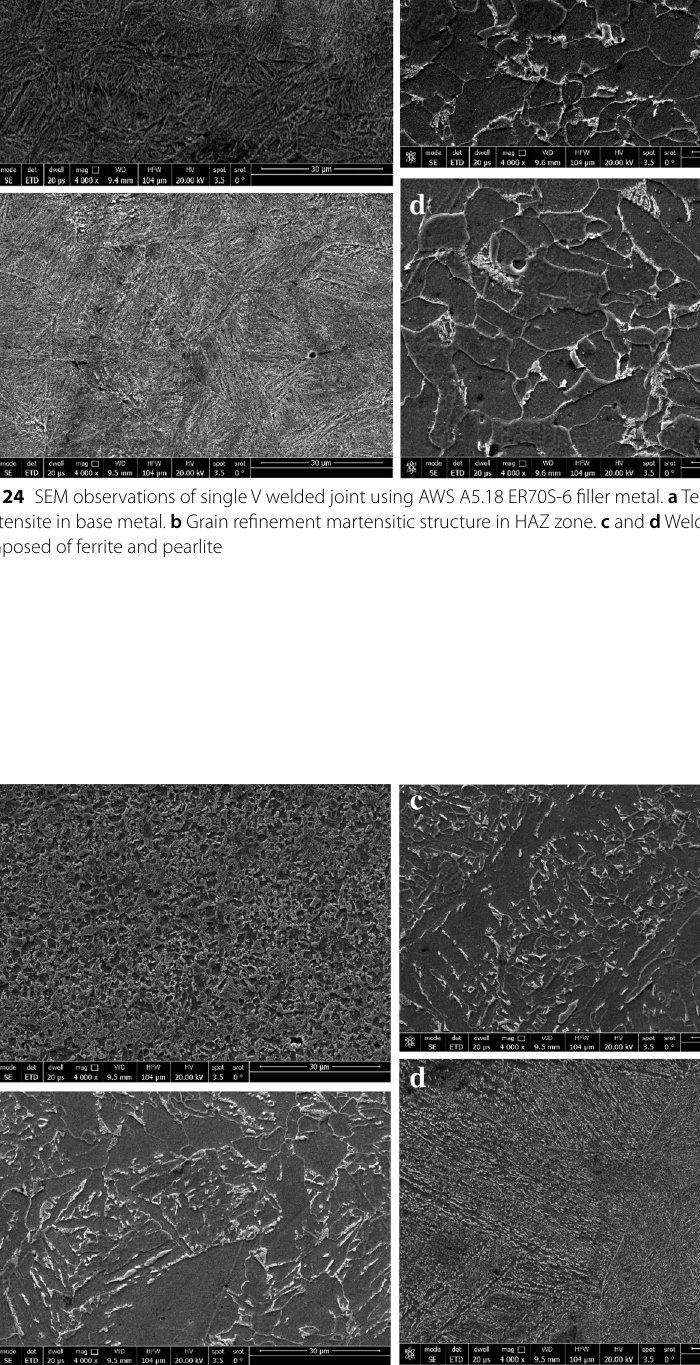
Fig. 25 SEM observations of single bevel welded joint using AWS A5.18 ER70S-6 filler metal. a Martensitic structure in HAZ zone, b , c , and d weld metal zone composed of columnar structure of ferrite and pearlite, and d martensite